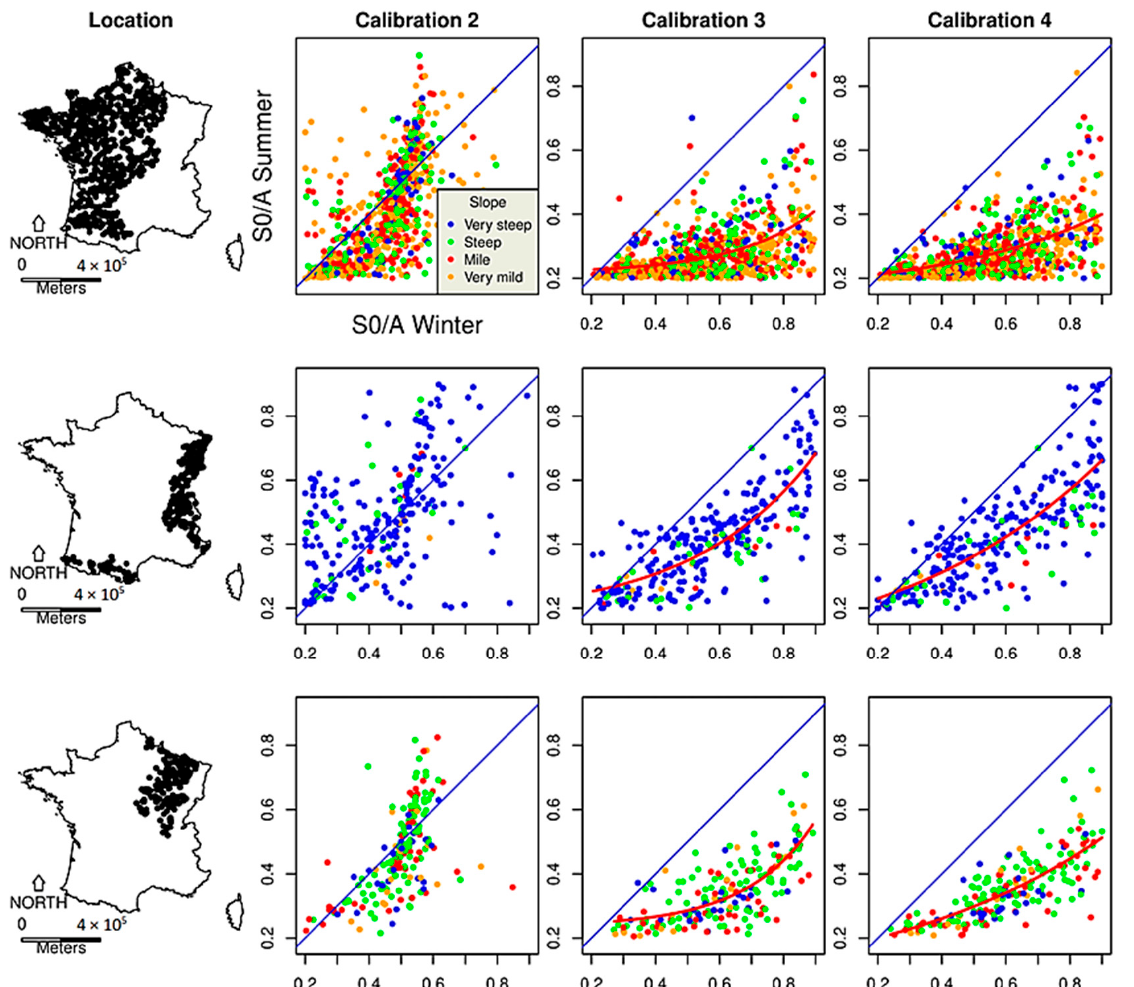
Figure 8. Classification of gauged catchments by their location and mean slope.